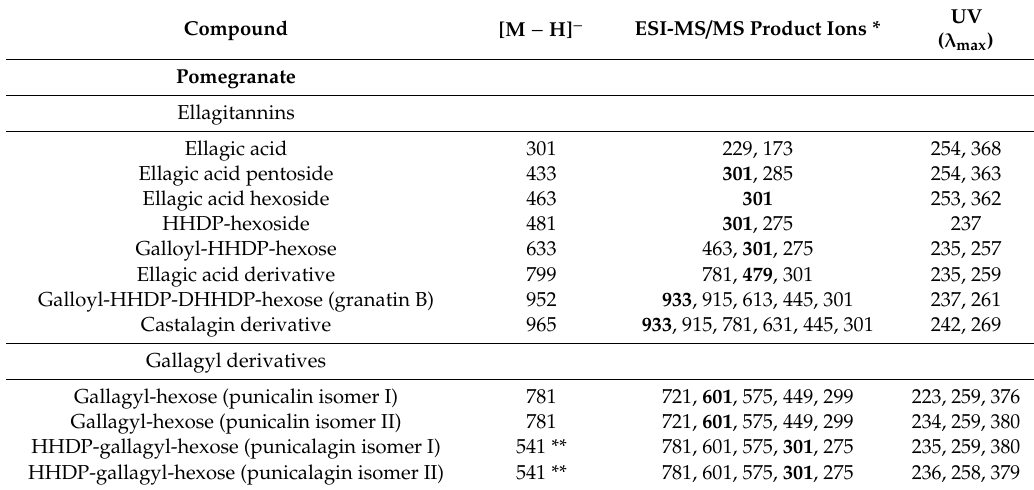
Table 4. Main components of the pomegranate peel extract.